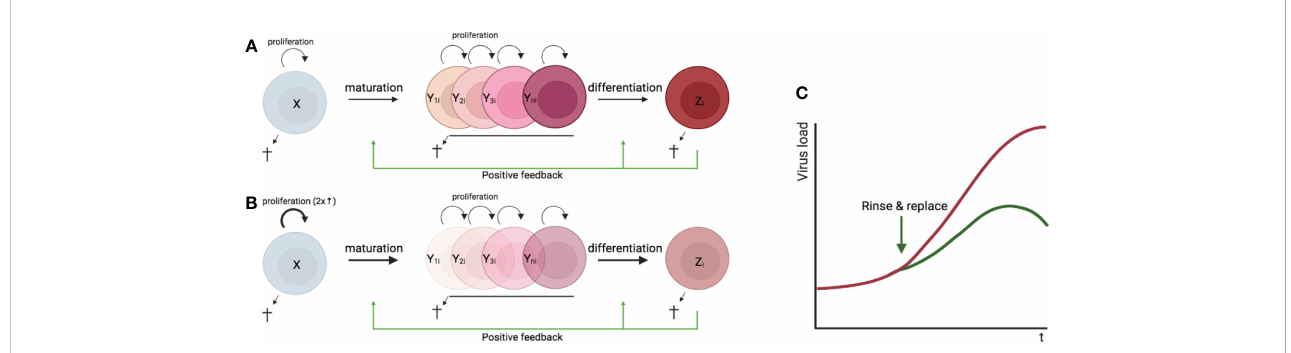
FIGURE 3 Schematic illustration of the effect of the “ rinse and replace ” strategy on SARS-CoV-2 infection. (A) Scheme illustrating the feedback-controlled balance- of-growth-and-differentiation model for virus infected lung epithelial cells. (B) Schematic illustration of the effect of a 2-fold increase of the proliferation rate of X cells. (C) The kinetics of virus load progression over time for baseline conditions and after a 2-fold increase of the proliferation rate of the progenitor cells. X, progenitor cells; Yki, (k = 1, 2, … , n), infected AT2 cells in different maturation stages; Zi, infected terminally differentiated cells belonging to the index subset of AT1 cells (see